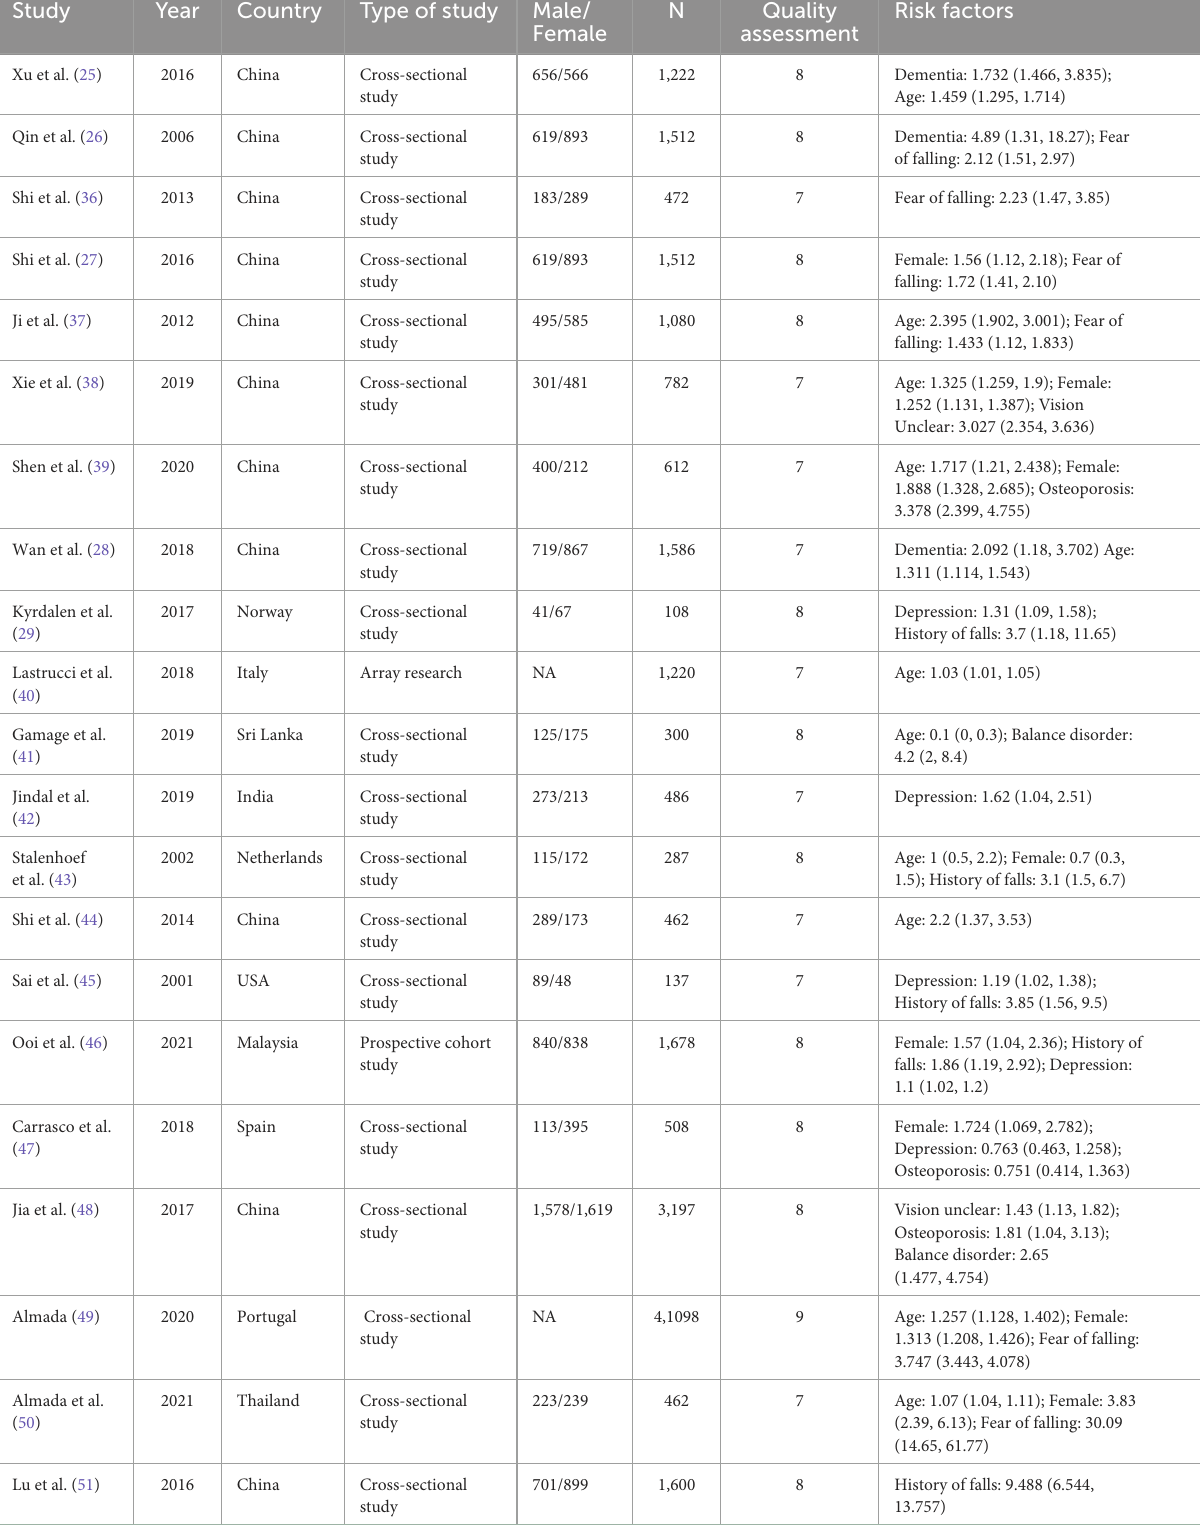
TABLE 2 Study and characteristics of the participants.